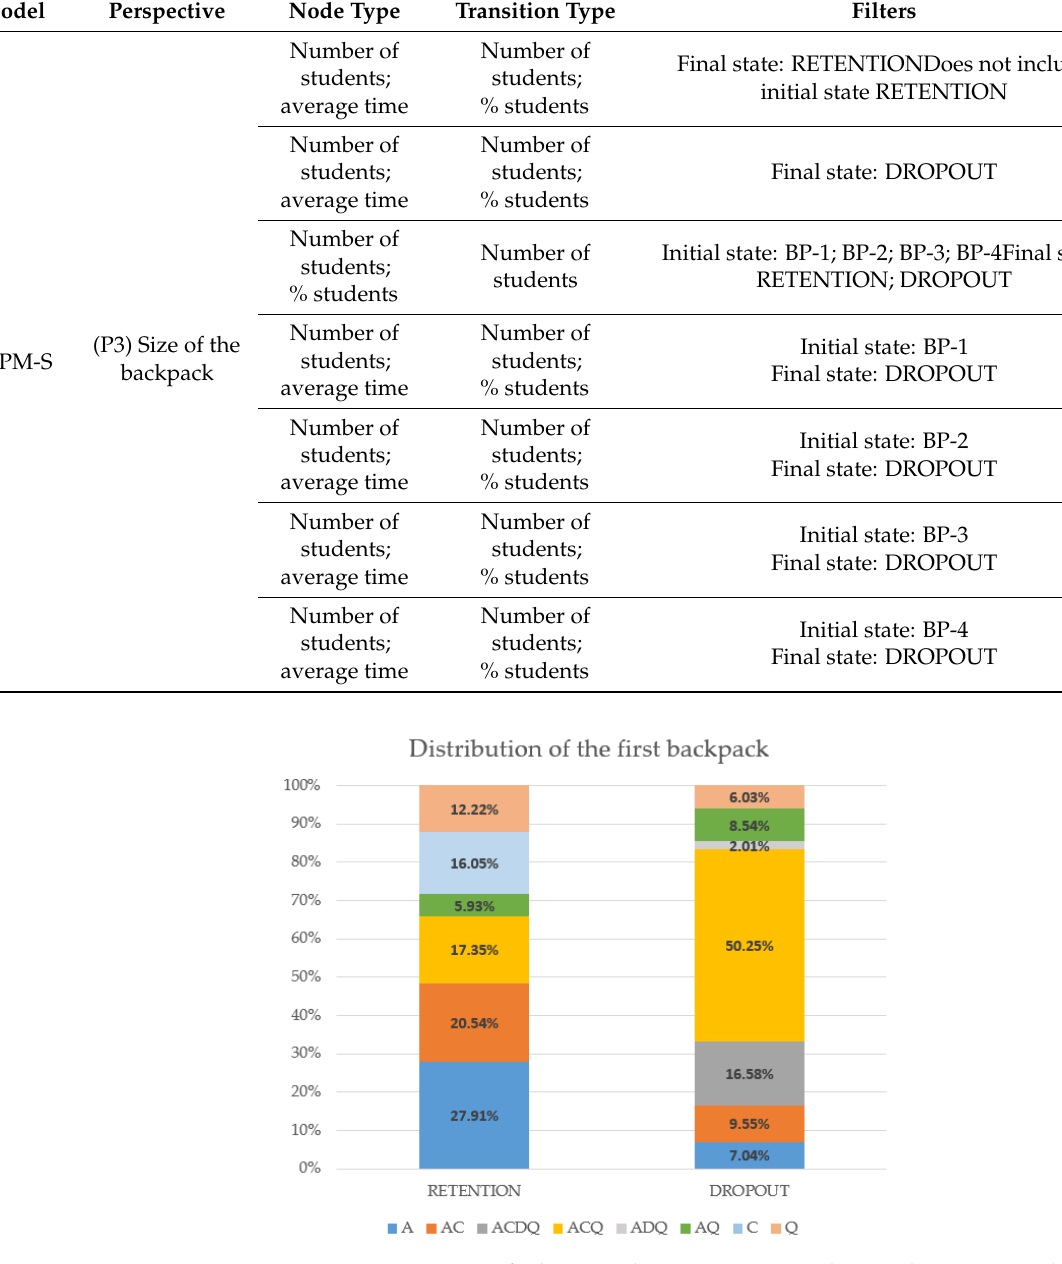
Figure 4. Percentage of educational trajectories, according to the BPPM model, that started with each backpack. The graph considers only the most frequent variants for each model, corresponding to 80% of the students. The RETENTION column considers only students who had a backpack and emptied it (1383 cases, seven more frequent variants). The DROPOUT columns consider only students who had a backpack, were not able to empty it and finally dropped out (199 cases, 13 more frequent variants).